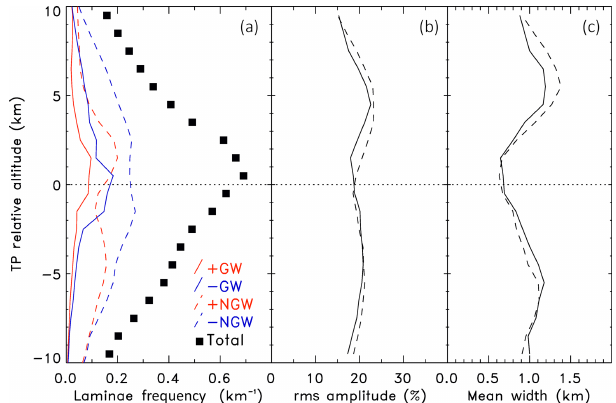
Figure 5. Vertical profiles of ozone laminae characteristics in alti- tude coordinates relative to the WMO tropopause. Panel (a) shows laminae frequency as the number of laminae detected per sound- ing within 1km wide altitude bins. Black squares are for all lami- nae types and signs. Solid lines show frequencies of GW laminae, dashed lines indicate NGW laminae, and red and blue colors indi- cate positive and negative anomalies, respectively. Panels (b) and (c) show profiles of rms amplitudes and mean widths, respectively. The rms amplitudes are derived from the square of the mean rel- ative anomaly within each lamina and averaged over all laminae detected within corresponding relative altitude bins. Widths are de- fined as the full altitude range in which the anomaly amplitude ex- ceeds 10% (along consecutive 100m sampling intervals), with a minimum restriction of 0.2km. As with panel (a) , solid and dashed curves denote GW and NGW laminae,